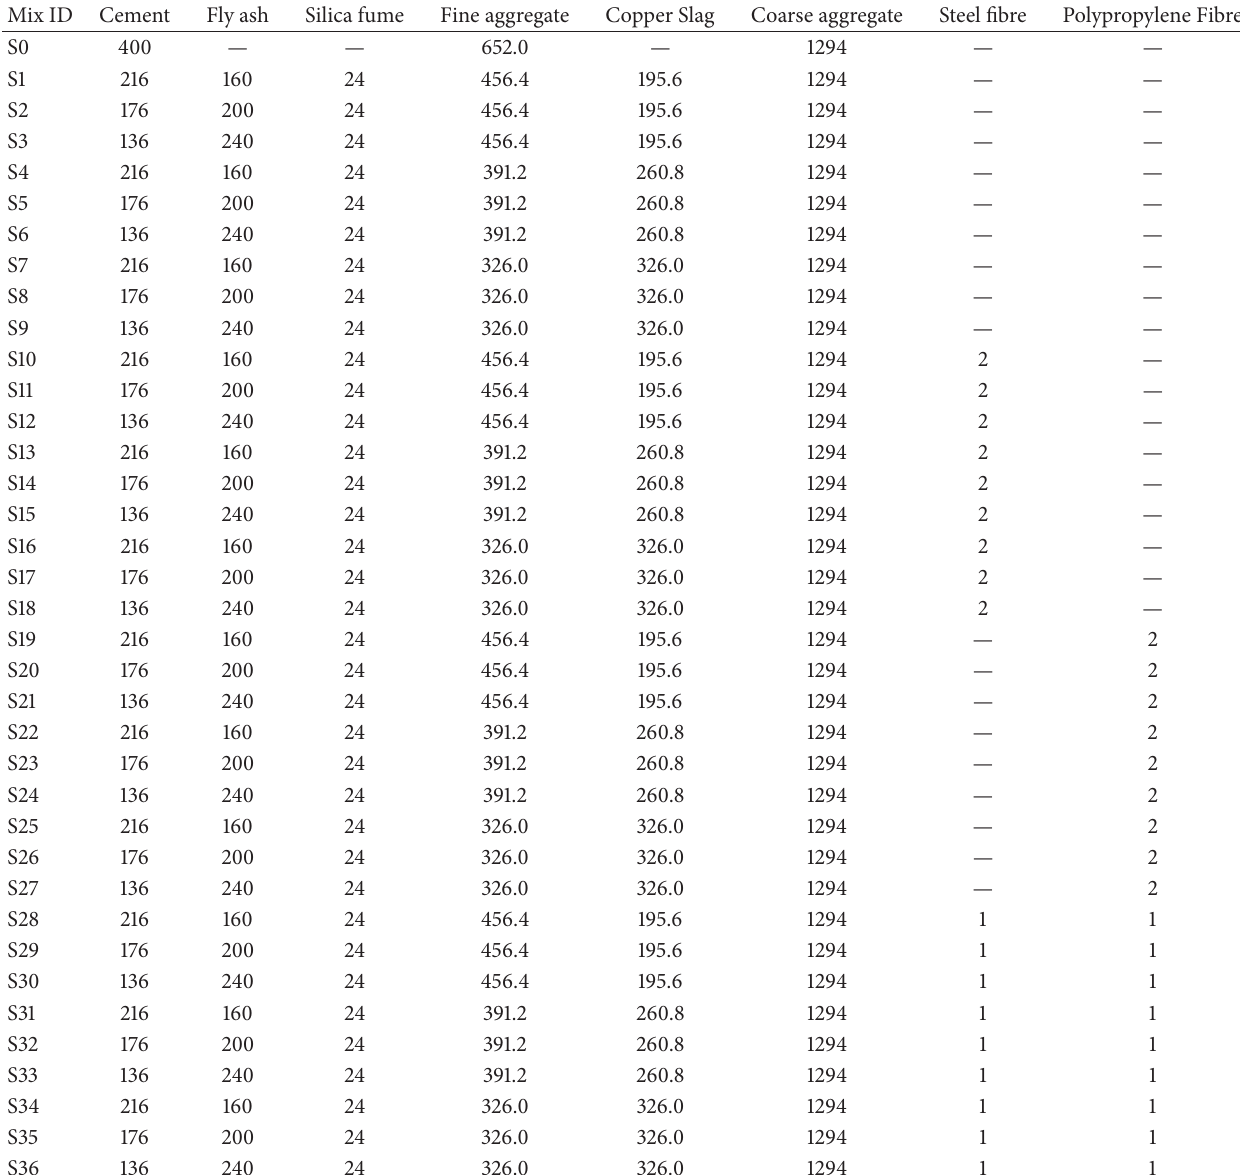
Table 1: Mix proportions (in kg/m 3 ) considered for experimental